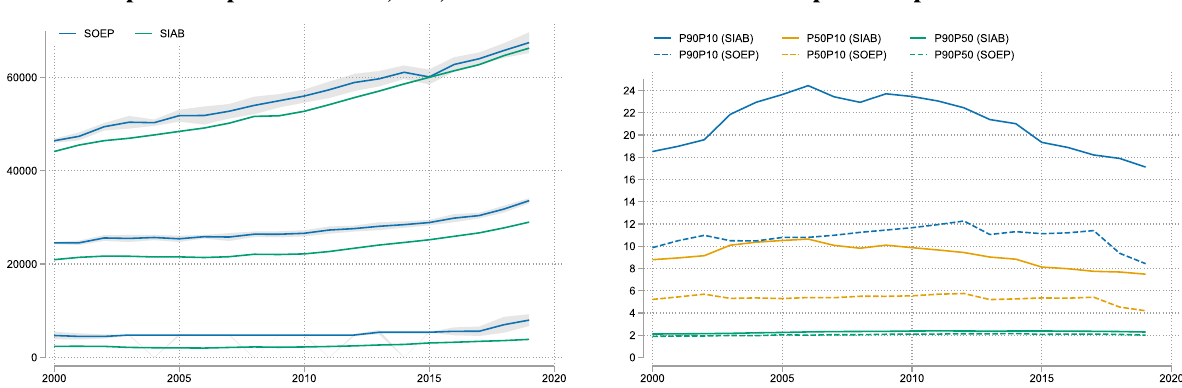
Fig. 4 Annual wages in 2000–2019; sample: comparable sample; no lower limit. Source: own calculations, SOEP-Core.v37.EU & SIAB 7519. 95% confidence interval indicated by shaded areas (for percentiles only); 500 bootstrap